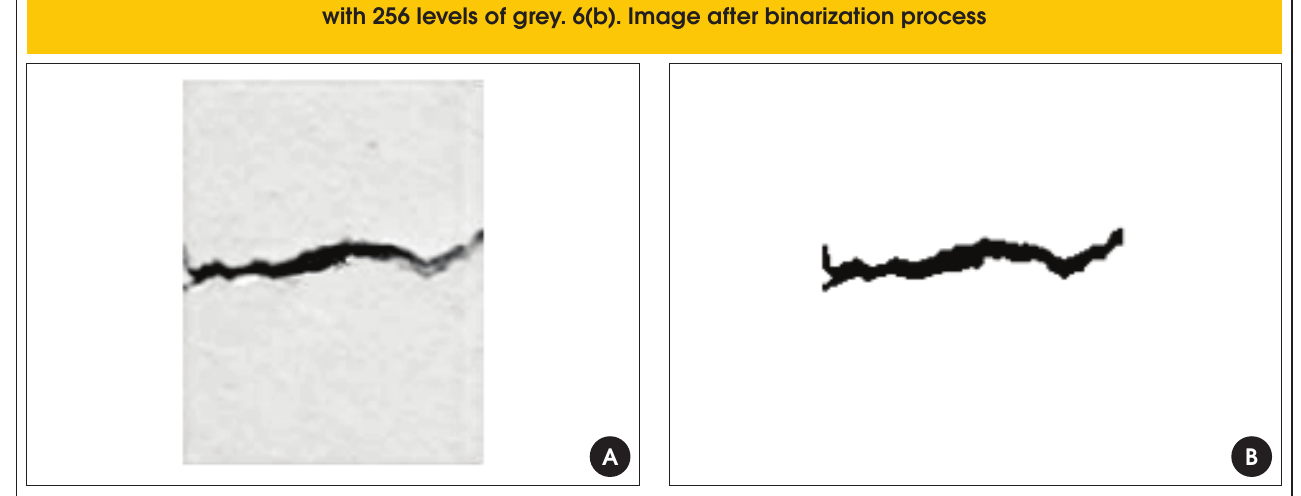
Figure 6 – (a). Image of crack on masonry represented in Gray-level with 256 levels of grey. 6(b). Image after binarization process